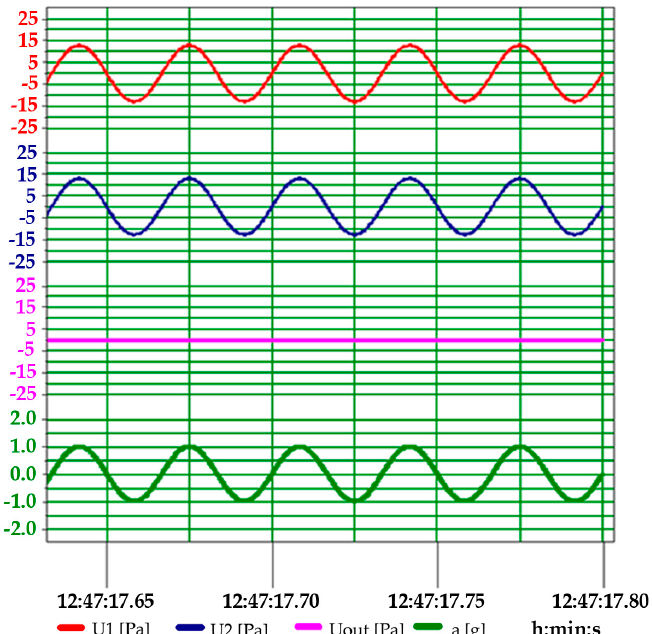
Figure 14. Waveforms of the experimental values of acceleration (a), pressure (p), and output signals (U 1 ; U 2 ; U out ) for dynamic acceleration with vibrations and with an amplitude of 1 g, frequency of f = 30 Hz, and pressure excitation of p = 0 Pa for the double-membrane